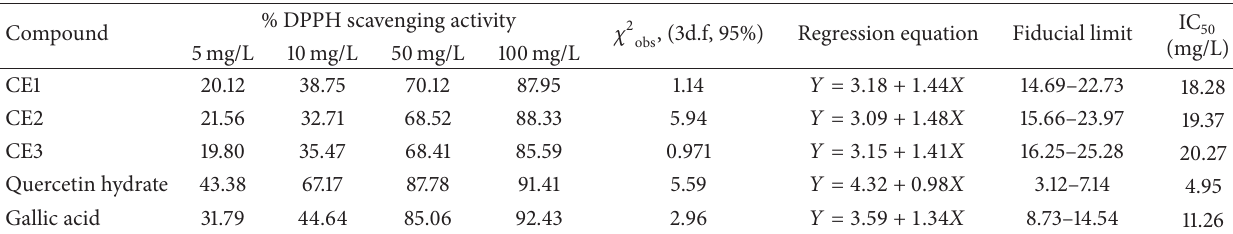
Table 1: IC (mg/L) and DPPH scavenging activity (%) of Rheum emodi (rhubarb) extracts. 50 % DPPH scavenging Compound